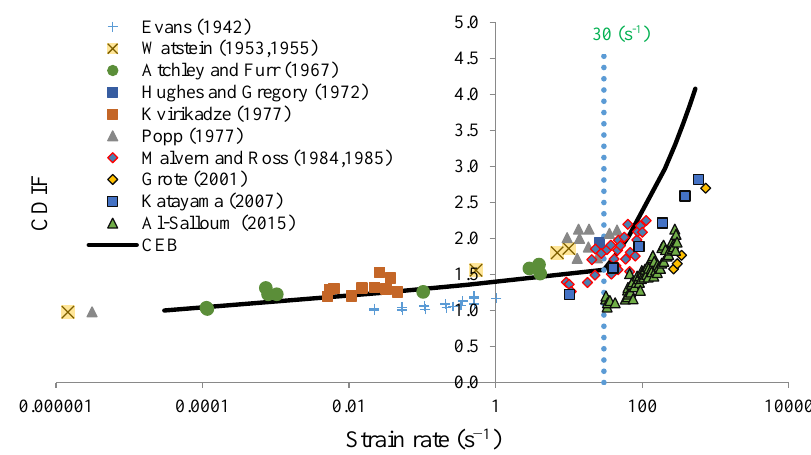
Figure 3. The compressive dynamic increase factor (CDIF) for concrete as a function of the strain rate.